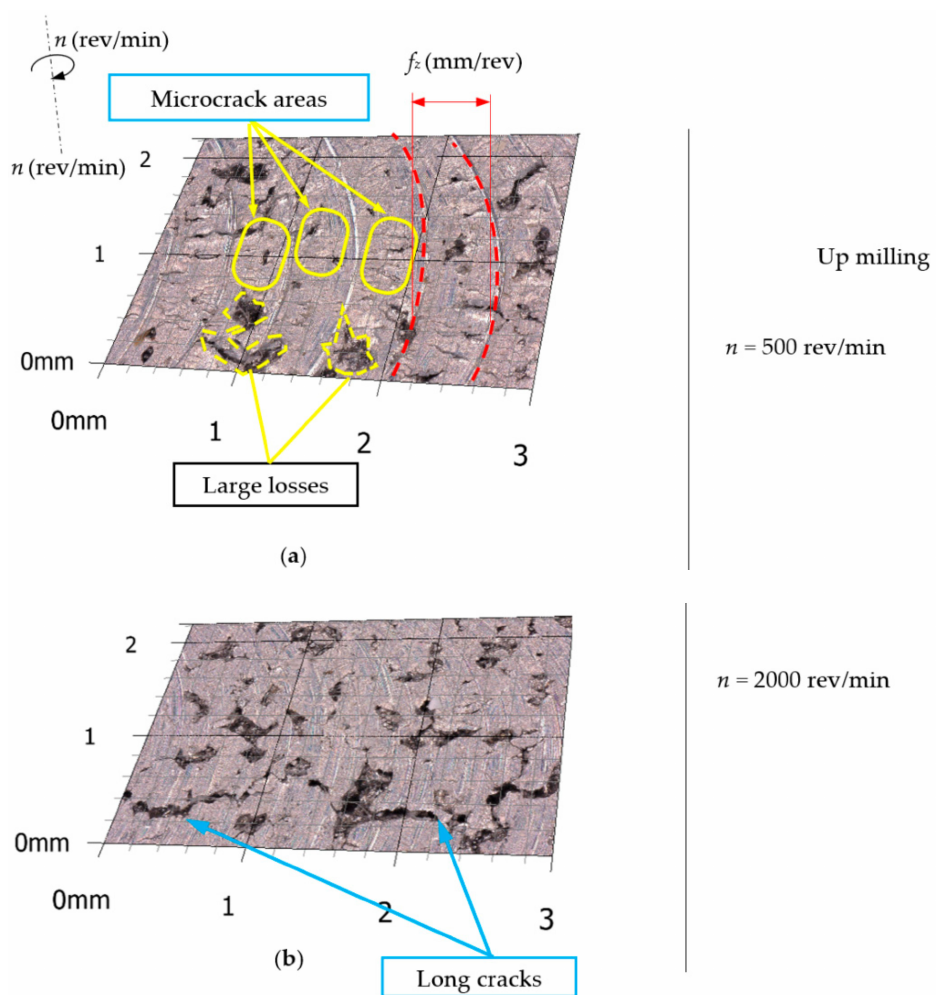
Figure 4. Example of 3D microscope surface measurement after up milling. ( a ) n = 500 rev/min. ( b ) n = 2000